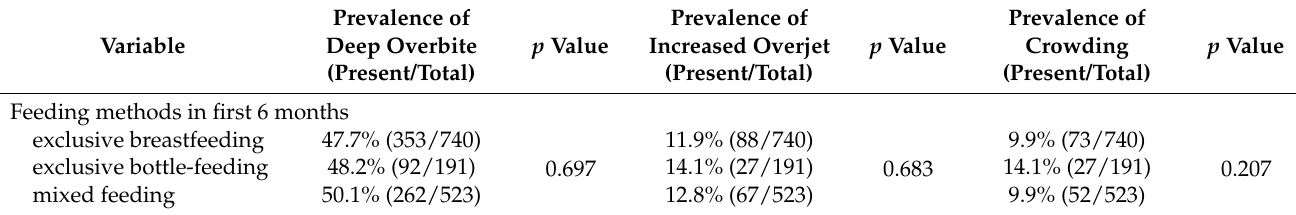
Table 5. Association between feeding/delivery methods and